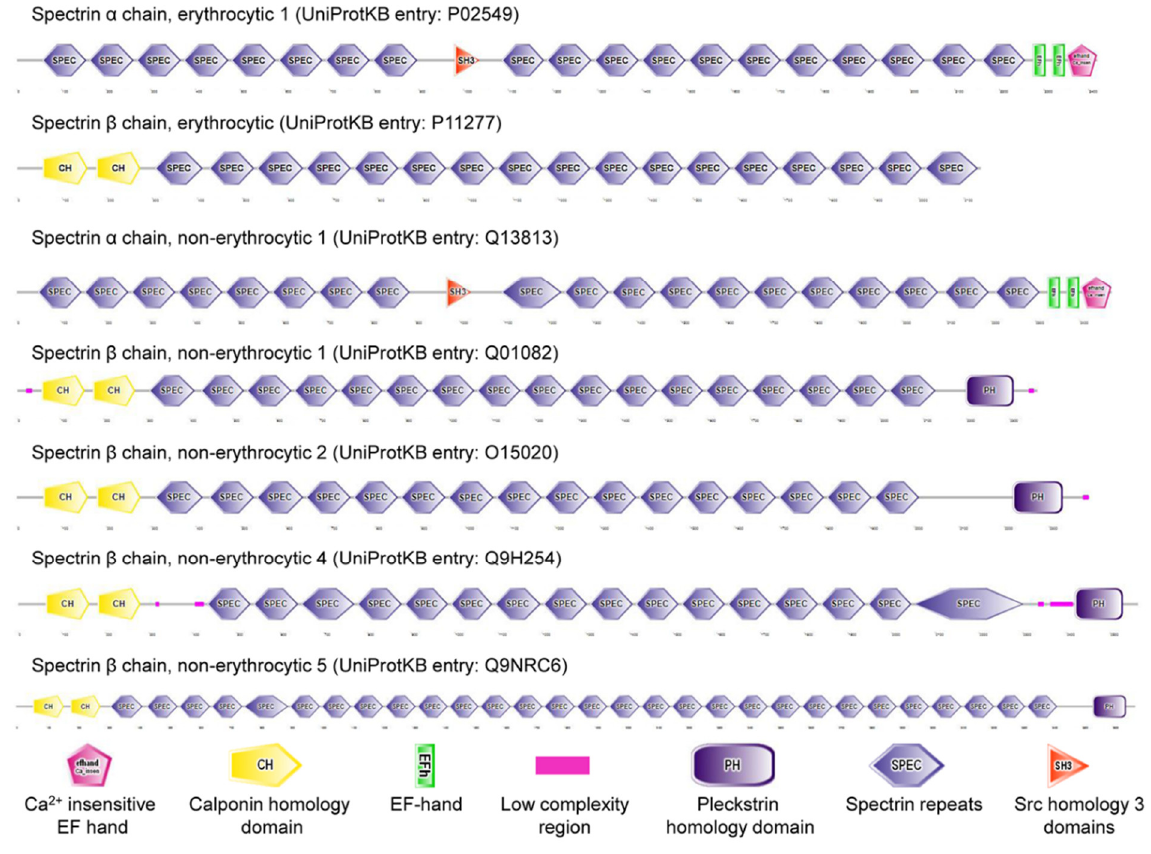
Figure 1. Spectrins in Homo Sapiens .